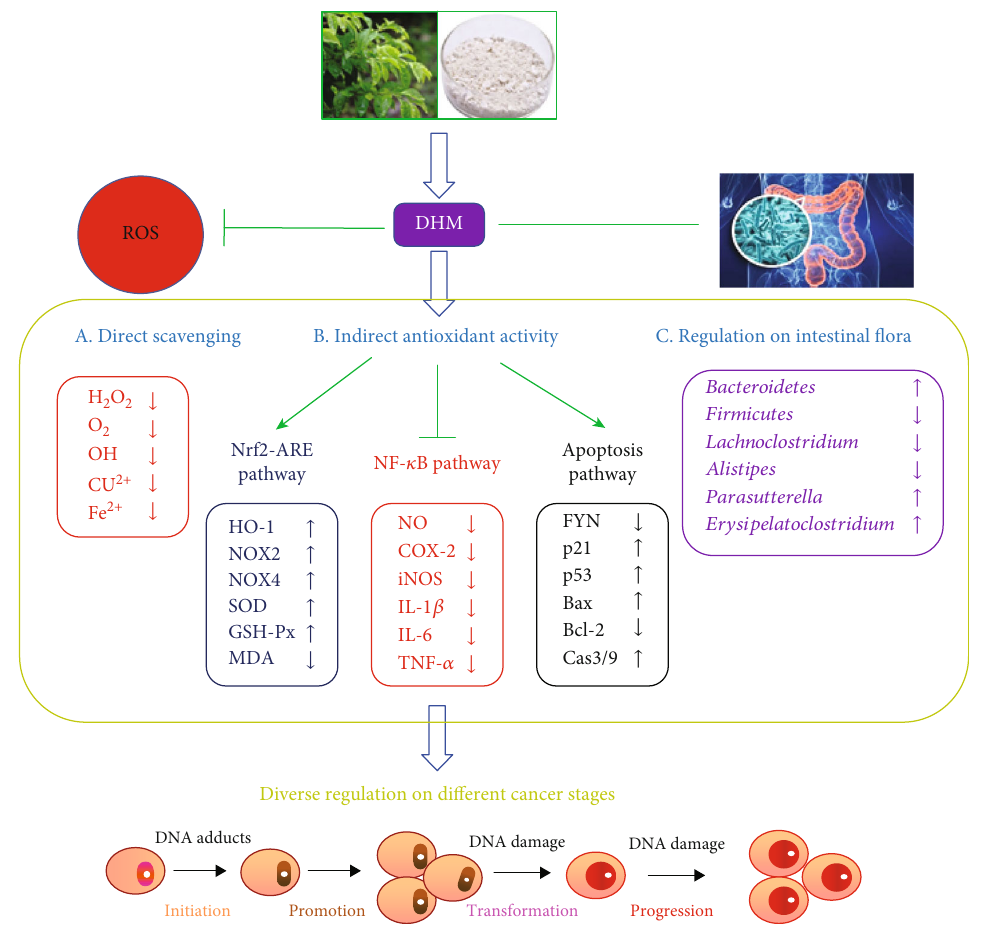
Figure 2: Molecular mechanism diagram of the inhibitory e ff ect of DHM on